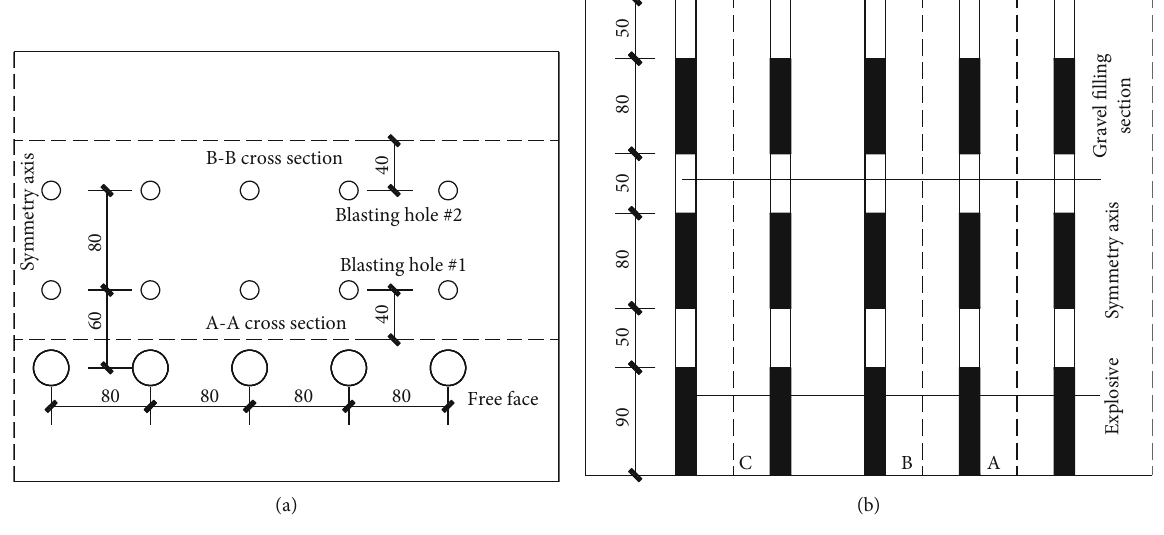
Figure 19: Cross section diagram (unit: